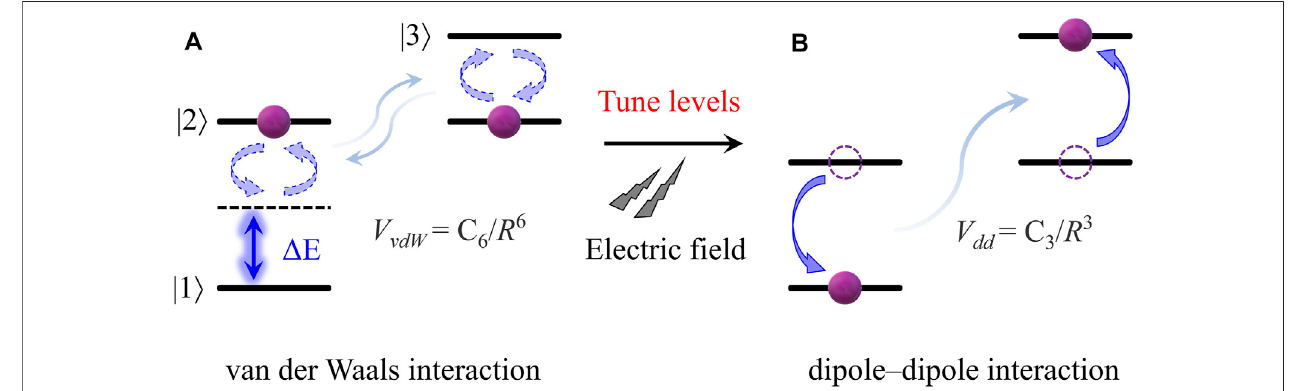
FIGURE1| (coloronline). (A) SchemeofthevanderWaalsinteractionbetweenRydbergatomicpairs.TwoatomsinitiallypreparedinthesameRydbergstate|2 〉 ,| 1 〉 , and |3 〉 are the dipole allowed near states. Δ E indicates the energy defect between |3 〉 − |2 〉 and |2 〉 − |1 〉 . For the case of Δ E ≠ 0, the Rydberg pair displays the van der Waals interaction, which scales as R − 6 . (B) Scheme of the dipole – dipole interaction. The weak DC electric fi eld is used to tune the Rydberg level to the Förster resonance. For the case of Δ E = 0, the Rydberg pair displays the dipole – dipole interaction, which scales as R − 3 .